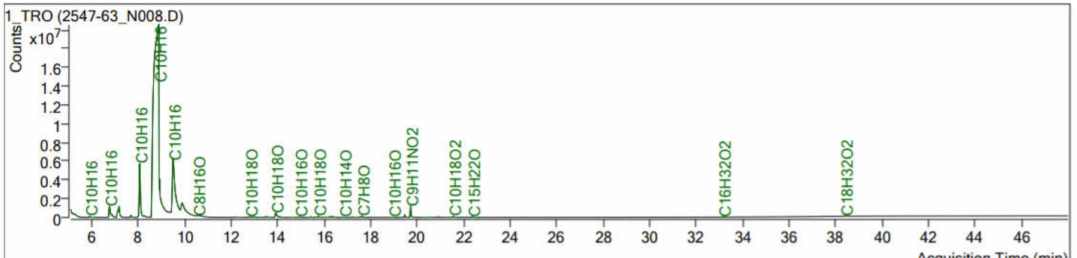
Figure 1. Chromatogram of tangerine essential oil analyzation using GC-MS technique.